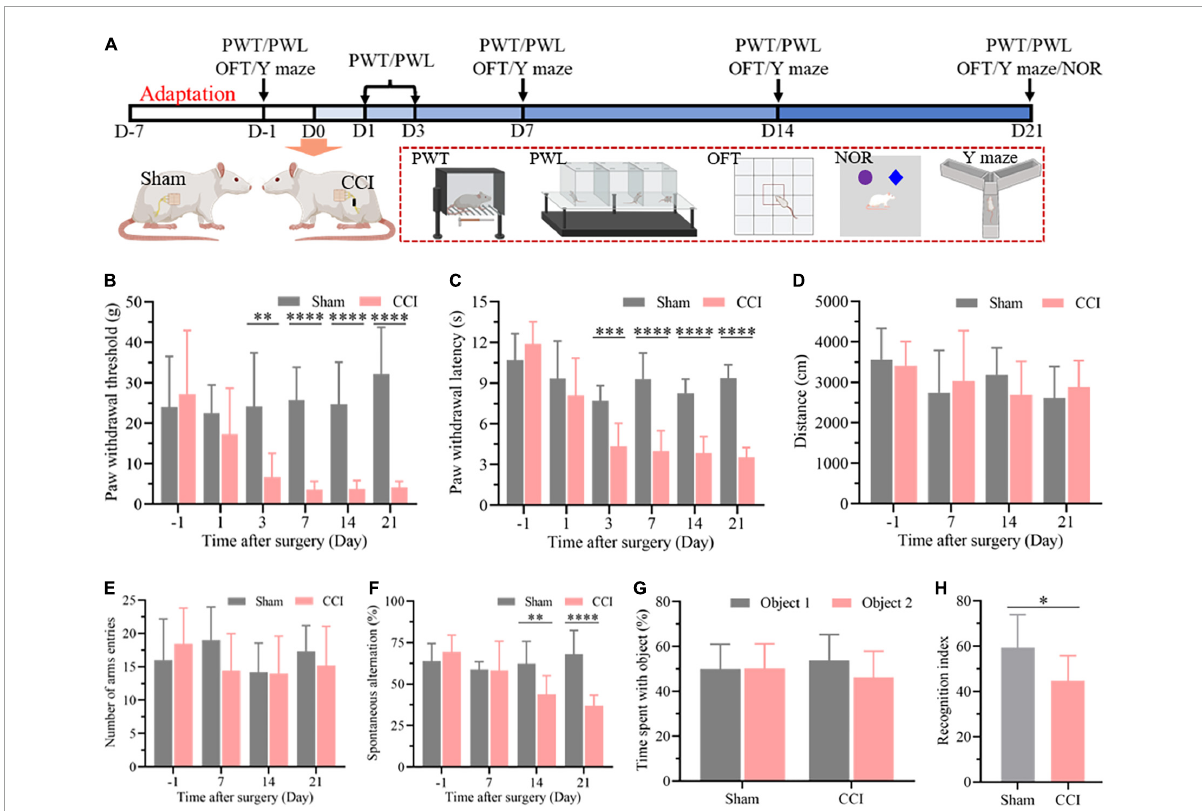
FIGURE1 CCI contributes to nociceptive hypersensitivity and cognitive impairment. (A) Flowchart diagrams show the timeline of the experimental procedures. PWT represent paw withdrawal threshold; PWL represent paw withdrawal latency; OFT represent open field test; NOR represent novel object recognition. (B) The PWT was determined by the von Frey method. (C) The PWL was tested on a thermal testing apparatus within 20 s. (D) Locomotor activity of the rats after surgery was detected by the total travel distance in the open field. (E) The number of arm entries and (F) spontaneous alternation were detected in each group through the Y maze. Data of (B–F) are presented as the mean ± SD ( n = 9), and the statistical analysis was conducted via unpaired Student’s t -test. ∗∗ P < 0.01, ∗∗∗ P < 0.001, ∗∗∗∗ P < 0.0001. (G,H) In the NOR test, investigation time of objects was recorded in the training and test periods, and the discrimination index was calculated in the test period. Data are presented as the mean ± SD ( n = 12), and the statistical analysis was conducted via unpaired Student’s t -test. ∗ P <